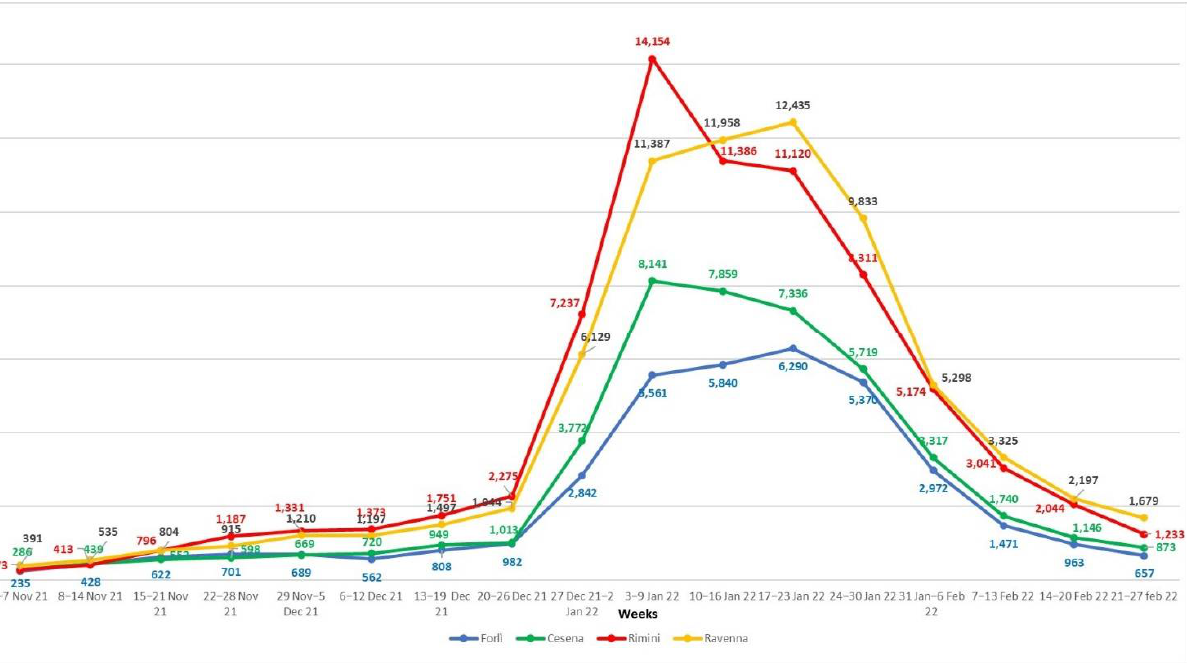
Table 2. Weekly percentage distributions of SARS-CoV-2 variants identified by viral genome sequencing in new positive samples of the Romagna territory.